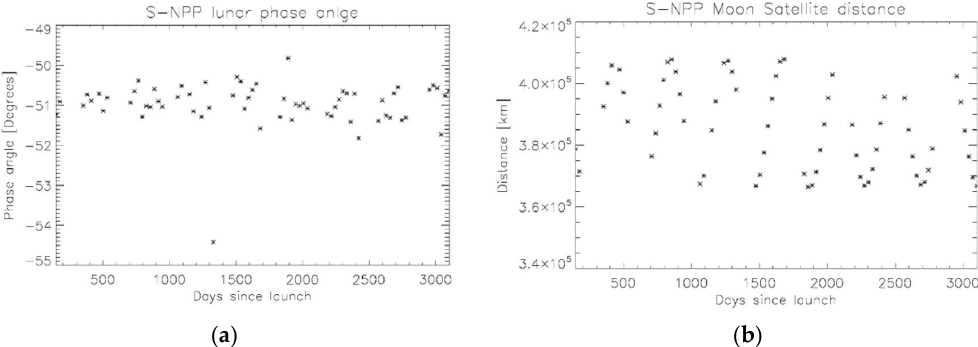
Figure 10. Lunar phase angles ( a ) and the distance between moon and satellite ( b ) for the scheduled lunar collections.